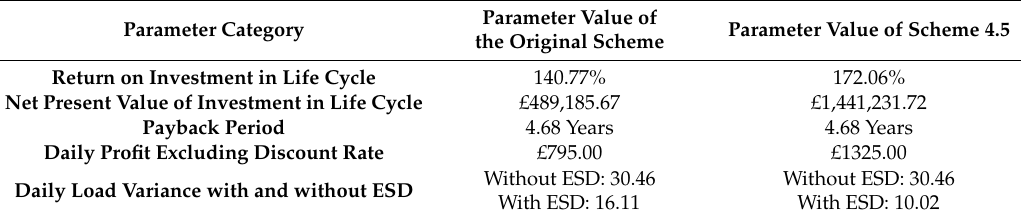
Figure 11. Comparison of load profile of Scheme 4.5 with the original scheme. T able 5. Comparison of parameters of Scheme 4.5 with the original scheme.